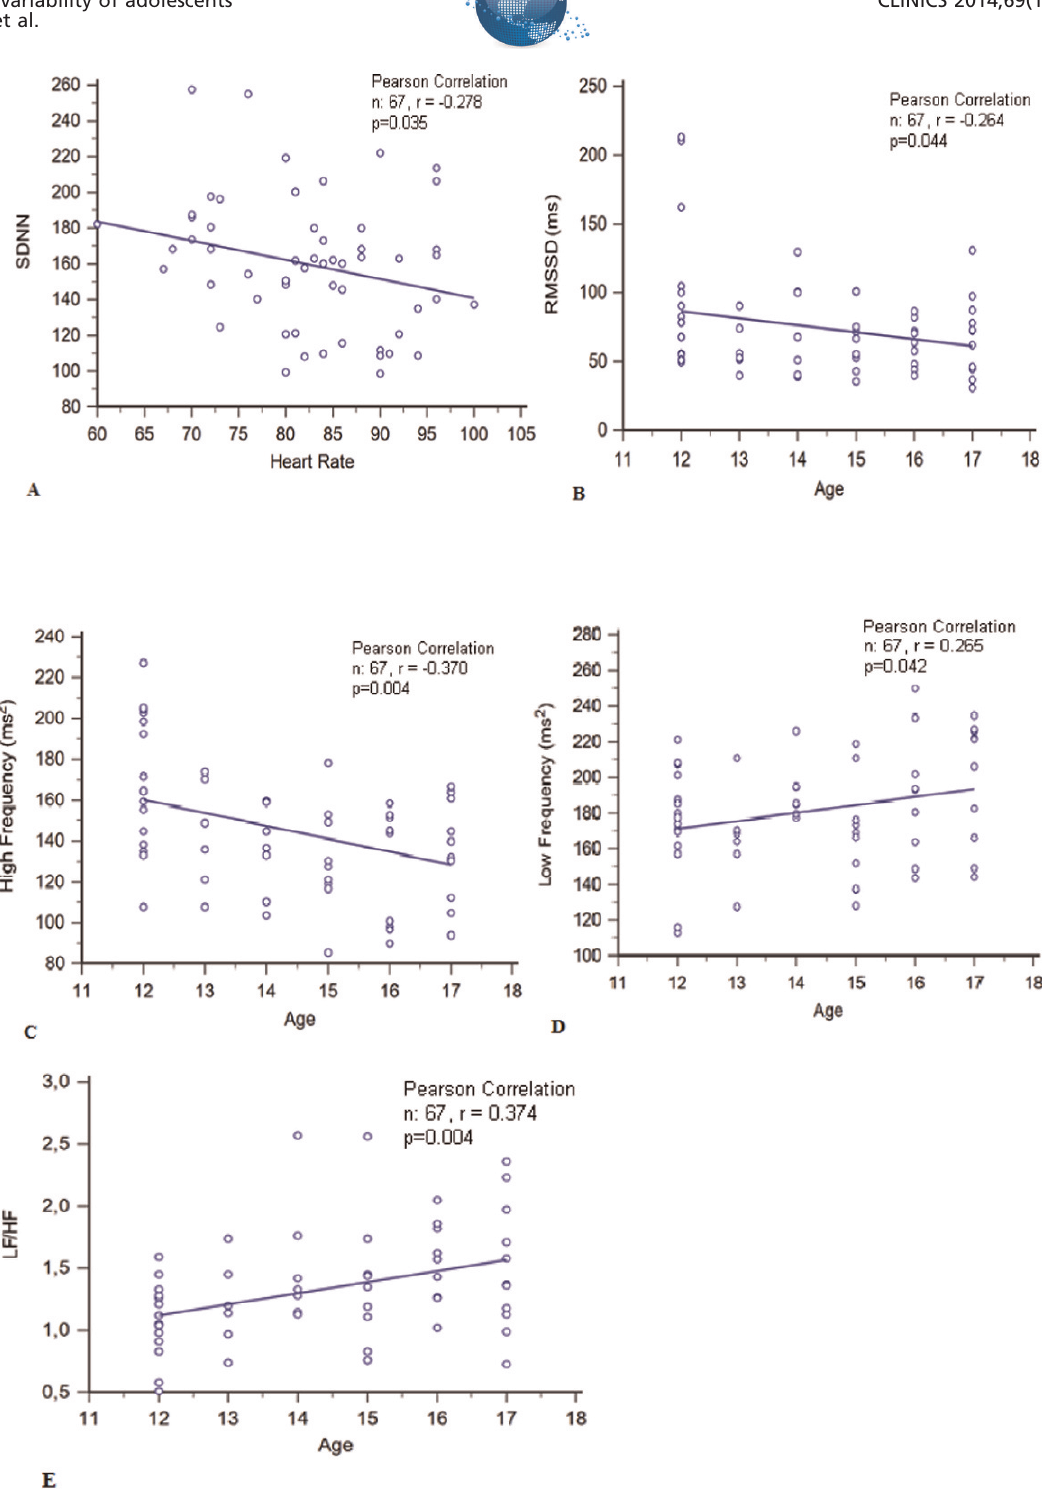
Figure 1 - Pearson correlation analysis of the following variables: heart rate and SDNN (A), age and RMSSD (B), age and HF (C), age and LF (D) and age and LF/HF (E). SDNN: standard deviation of all normal sinus RR intervals; RMSSD: root-mean-square differences in successive RR intervals; LF: low frequency; HF: high